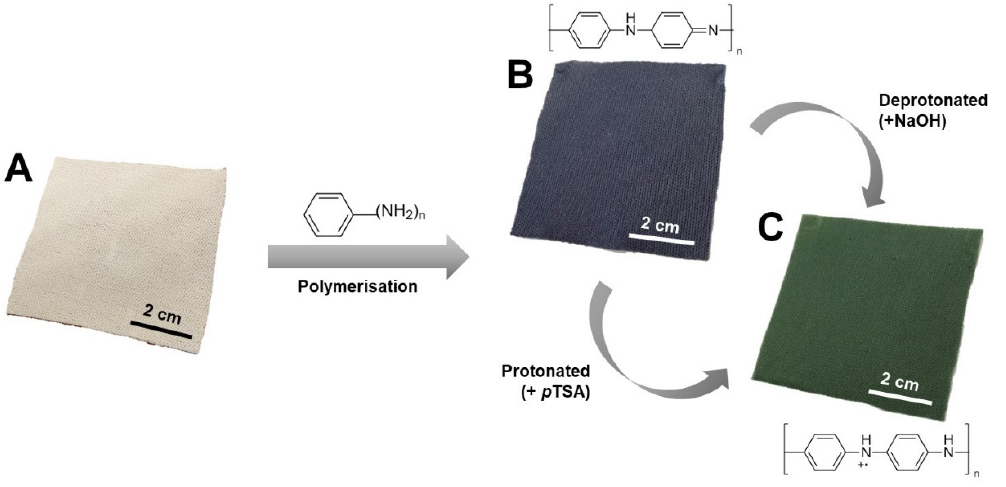
Figure 1. Close-up image of ( A ) bare PES fabric, ( B ) deprotonated, and ( C ) protonated PANI-integrated fabric.